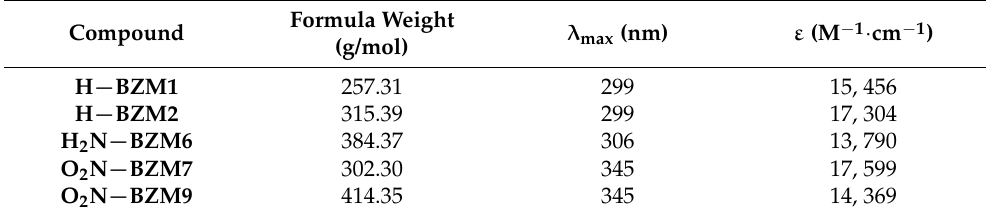
Table 5. UV molar extinction coefficients of compounds in aqueous phase. Percentage relative error < 5%.